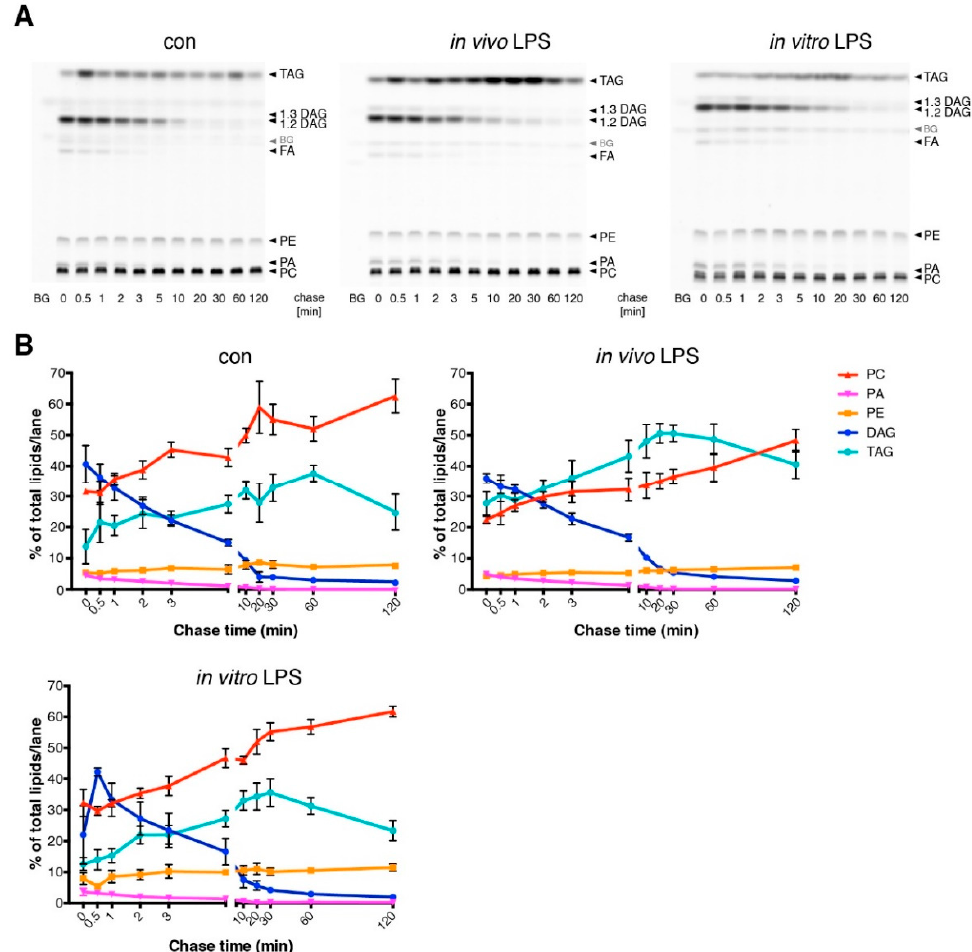
Figure 6. Di ff erential influence of in vivo or in vitro LPS stimulation on TAG synthesis in isolated hepatocytes. ( A ) Pulse-chase experiment with hepatocytes from untreated (con) or 1.5 h in vivo LPS-treated (LPS) mice. For comparison, hepatocytes from untreated animals were treated with 100 ng / mL LPS for 1.5 h (in vitro LPS). Pulse-chase analysis and lipid extraction were performed as described in Figure 2. ( B ) Quantification of the TLC plates shown in panel A ( n ≥ 3). Data are shown as mean values with SEM.